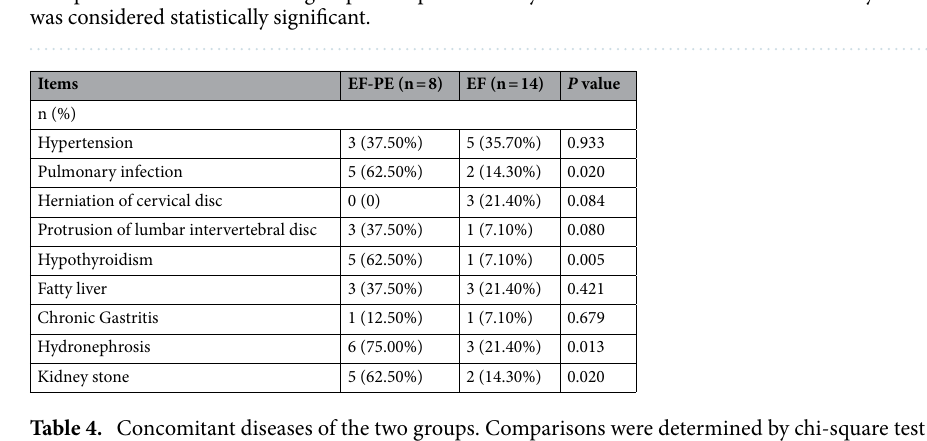
Table 4. Concomitant diseases of the two groups. Comparisons were determined by chi-square test or Fisher’s exact test. P < 0.05 was considered statistically significant.